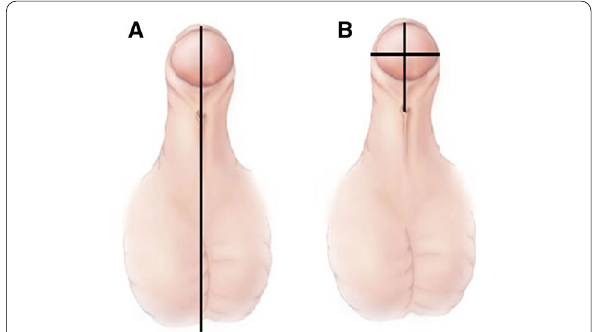
Fig. 1 Penile measurements: a Vertical line is Penoscrotal length. b Vertical line is Urethral plate length—horizontal line is Glans